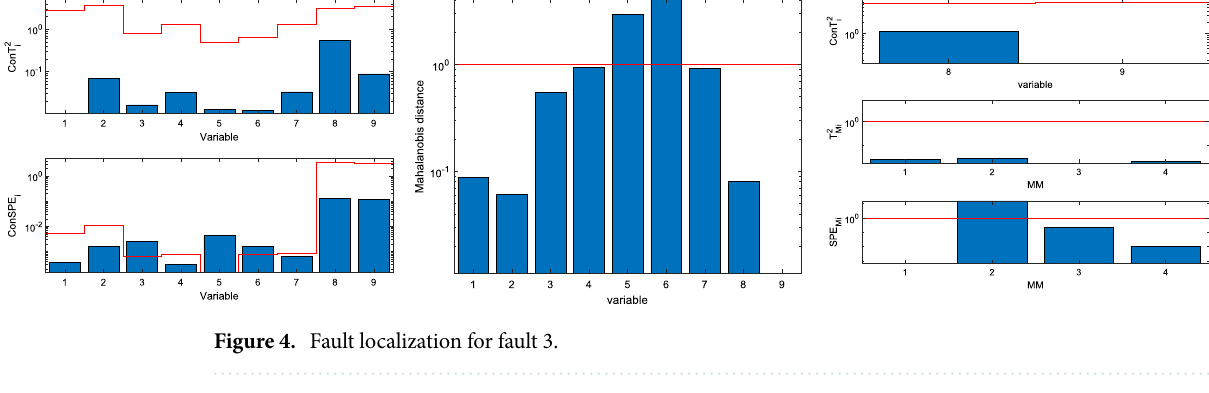
Figure 4. Fault localization for fault 3.